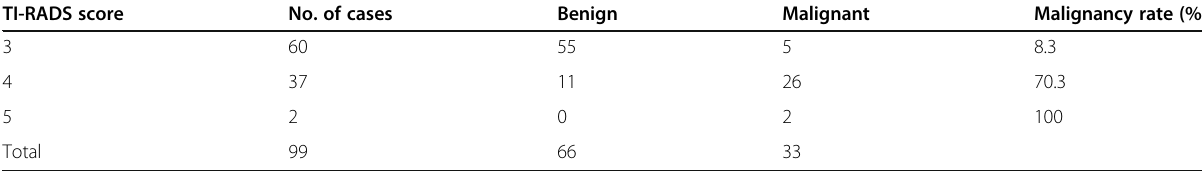
Table 8 Showing the malignancy rate according to the TI-RADS score of the 99 nodules after FNAC ± thyroid surgery TI-RADS score